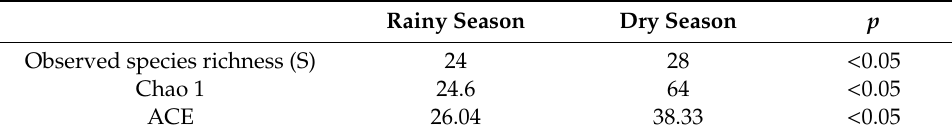
Table 3. Mosquito richness across seasons in Dschang, West-Cameroon.